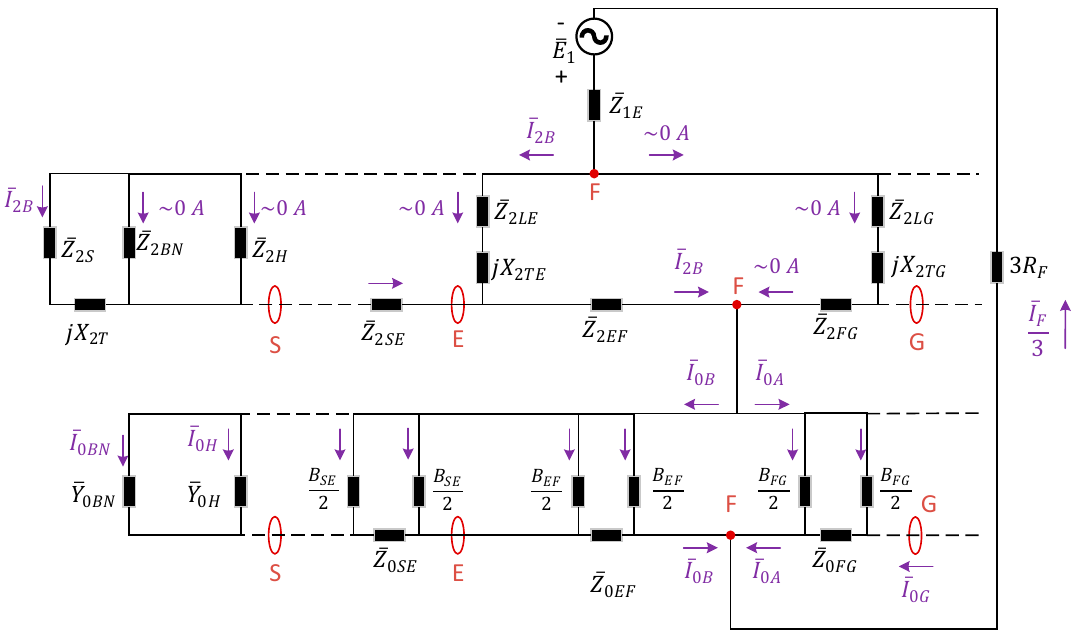
Figure 2. Symmetrical sequence equivalent circuit of the network shown in Figure 1.